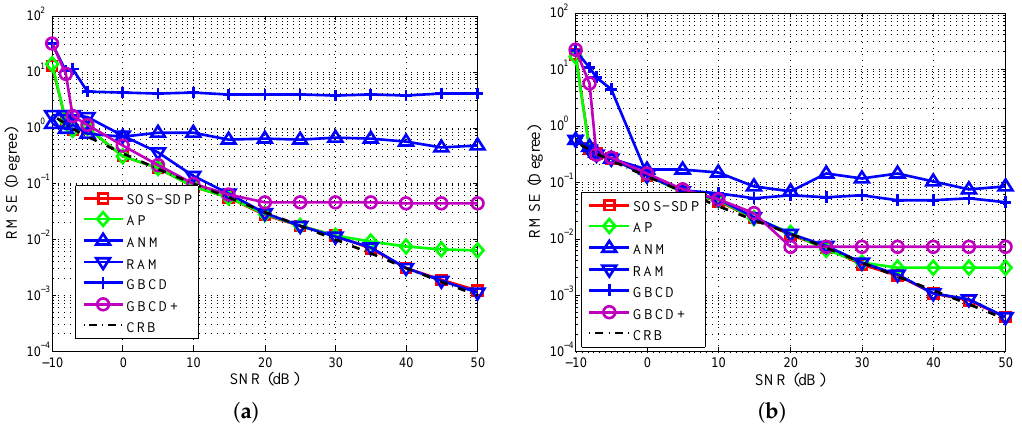
Figure 4. Comparison of RMSE of different methods and the CRB with N = 12, N t = 100, and M = 3 equal power uncorrelated sources. ( a ) RMSE of estimation of θ 1 versus SNR; ( b ) RMSE of estimation of θ 3 versus